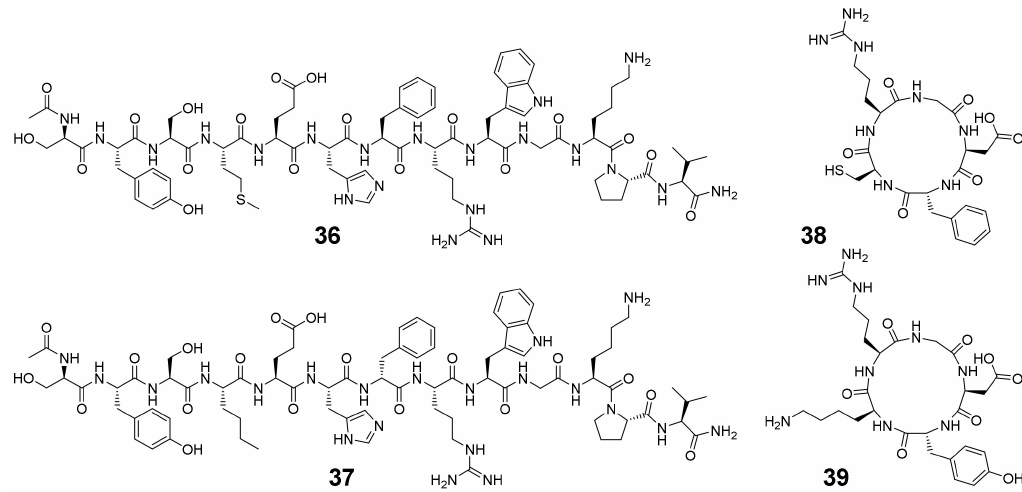
Figure 4. Structures of α -MSH ( 36 ), NDP ( 37 ), c(RGDfC) ( 38 ) and c(RGDyK) ( 39 ), which were used as monospecific reference peptides during the competitive displacement